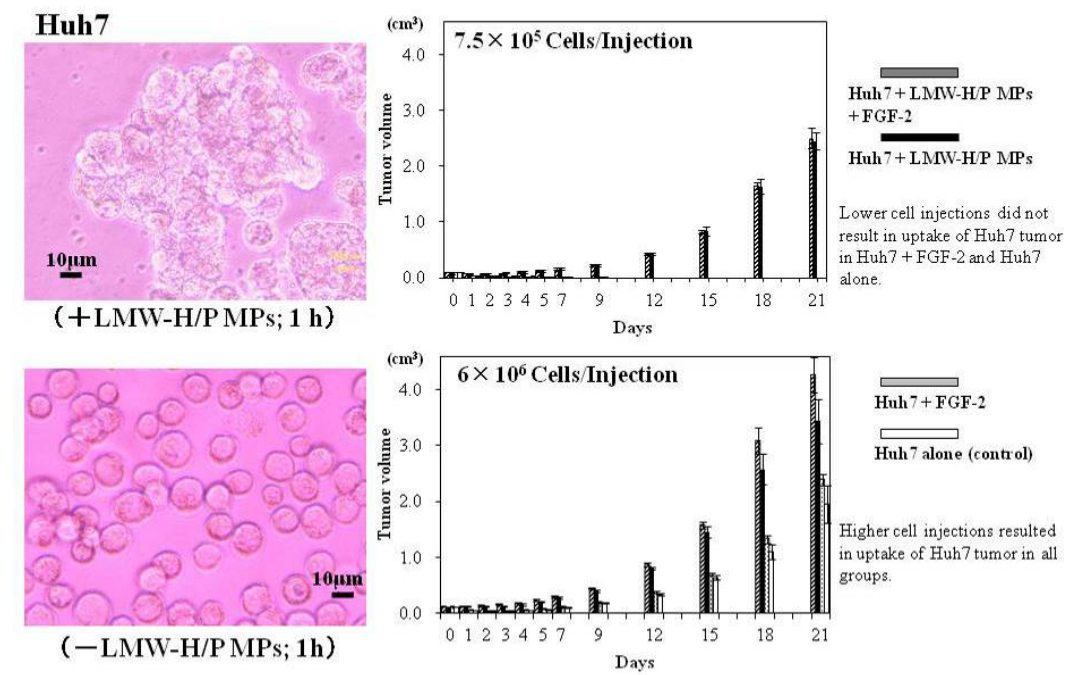
Figure 6. Huh7/LMW-H/P MPs aggregates and tumor formation and growth in nude